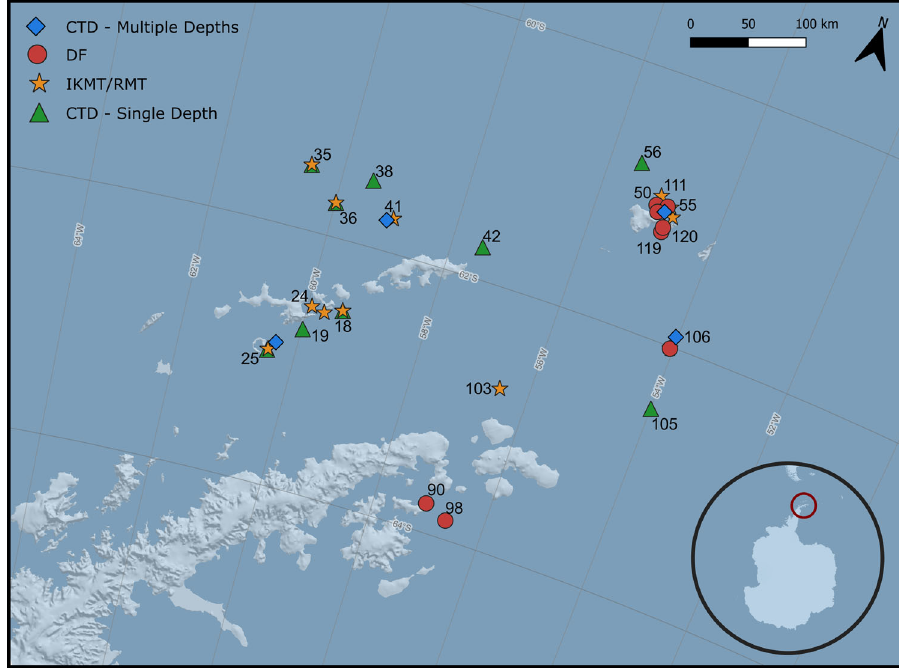
Fig. 1 Sampling stations and deployed devices at the Antarctic Peninsula. All sampling stations are shown (cf. Supplementary Table 3) along with symbols depicting the different sampling devices: Blue diamonds depict water samples collected with a CTD rosette at multiple depths, green triangles depict water samples collected with a CTD rosette at a single depth in the chlorophyll maximum layer. Yellow stars depict krill and salps collected by tows using IKMT or RMTs. Red circles depict drifting sediment traps, from which fecal pellets were collected. The map was created using the software Quantartica 98